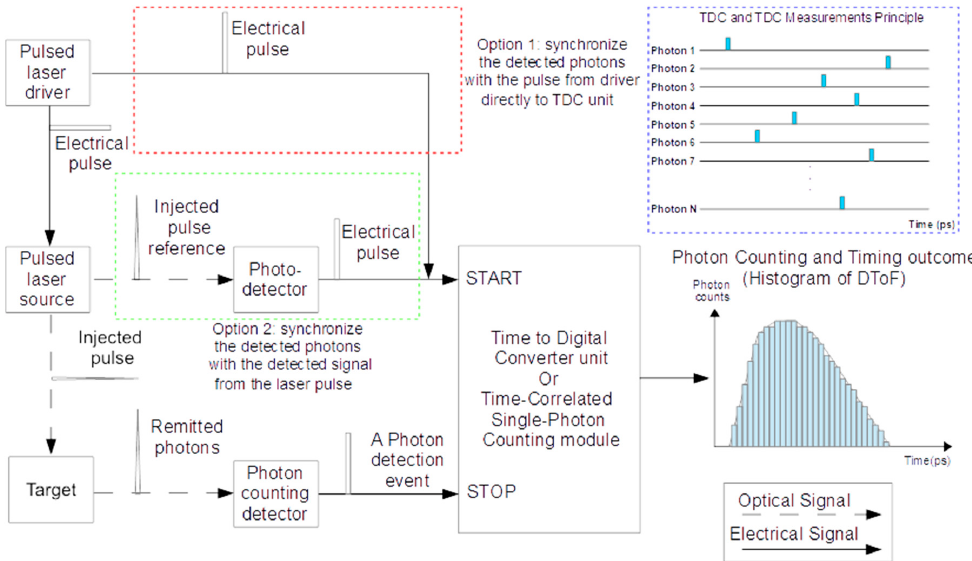
Figure 3. DToF histogram obtained by measuring the delay between laser pulse and PTA. Top-right (in red and green borders) shows two methods (to synchronize the laser pulse with the detected photons. Top-right (blue border) illustrates how the counted photons are stored in the DToF histogram according to the differences in delay for each one of them.